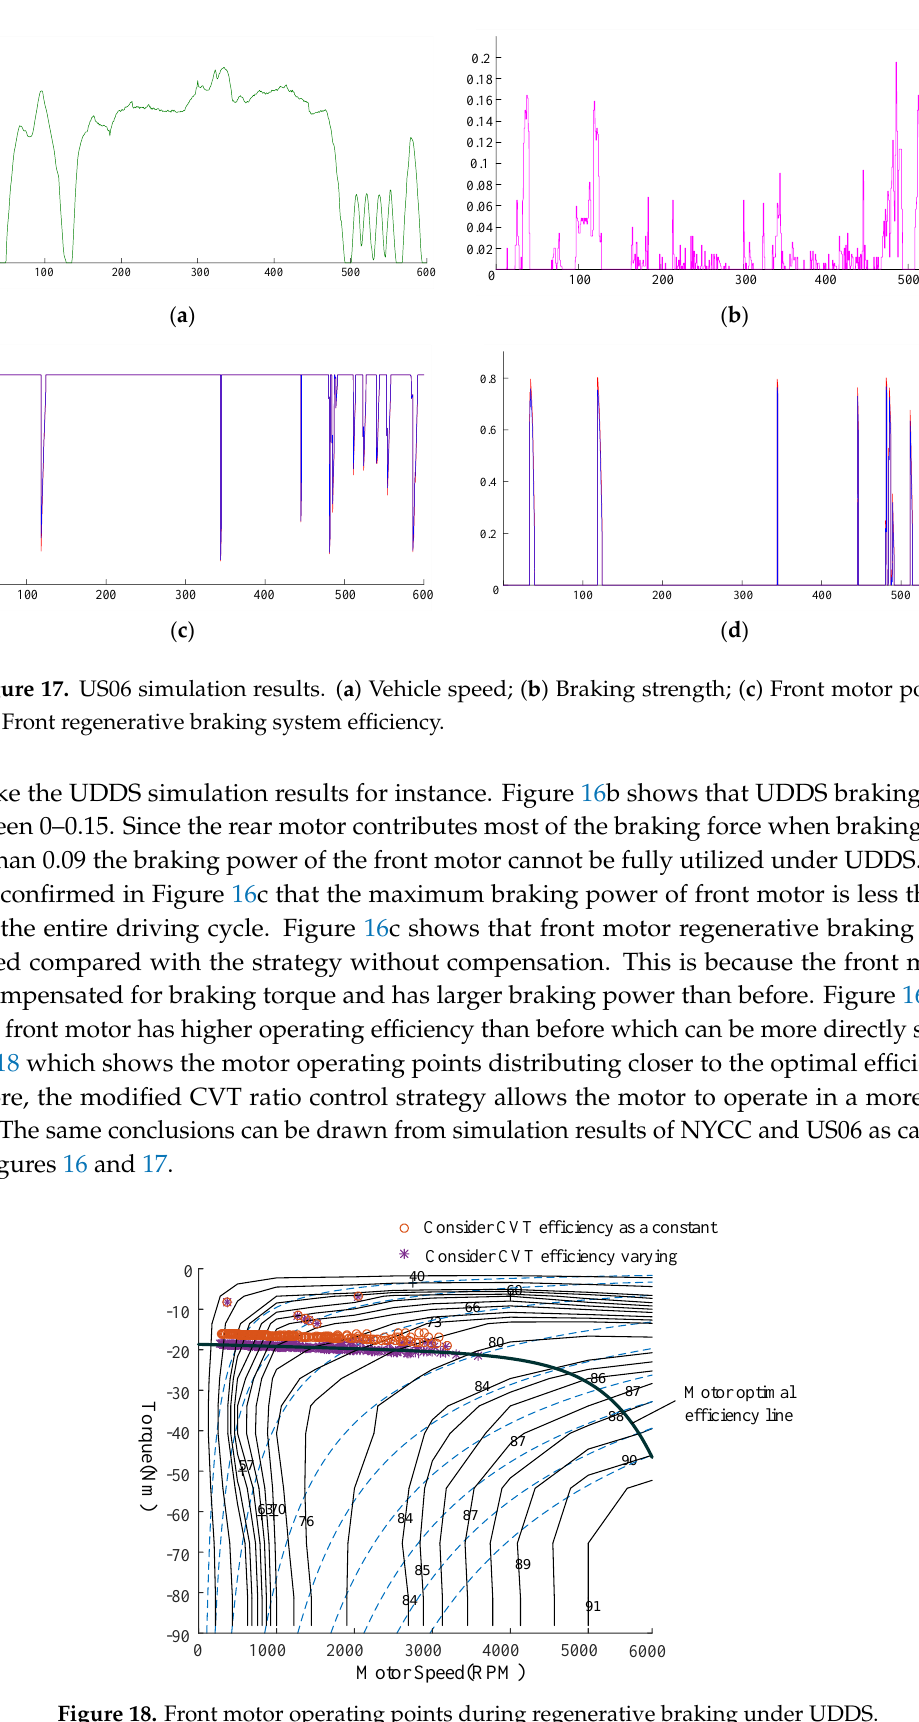
Figure 16. NYCC simulation results. ( a ) Vehicle speed; ( b ) Braking strength; ( c ) Front motor power; ( d ) Front regenerative braking system efficiency.